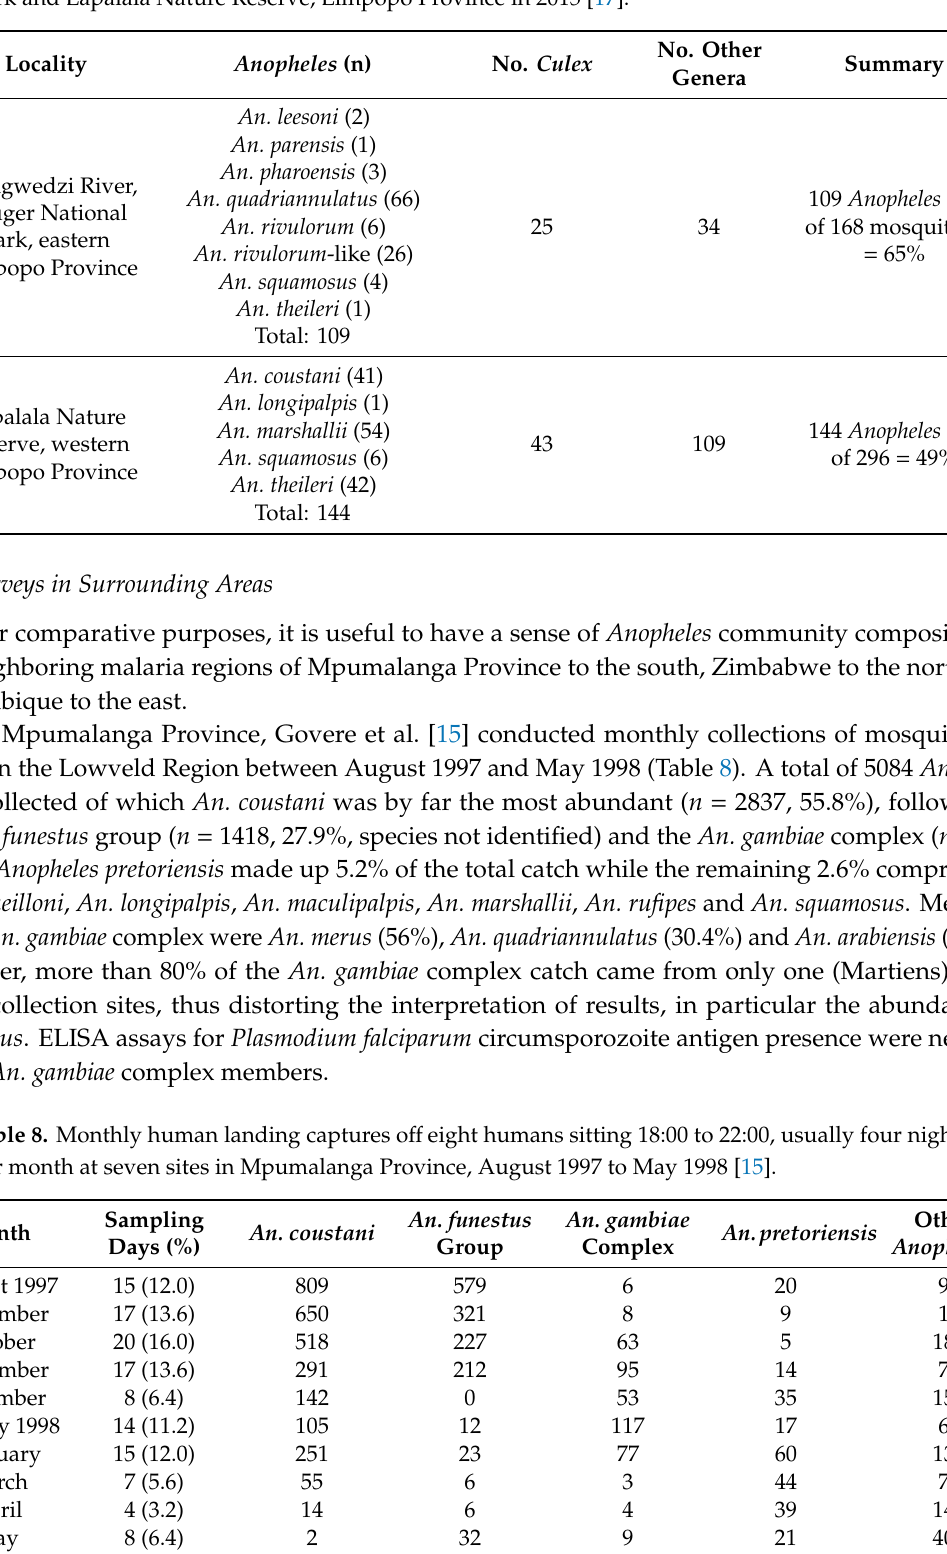
Table 7. Anopheles species collected by CO 2 -baited net and light traps at Shingwedzi, Kruger National Park and Lapalala Nature Reserve, Limpopo Province in 2015 [17].